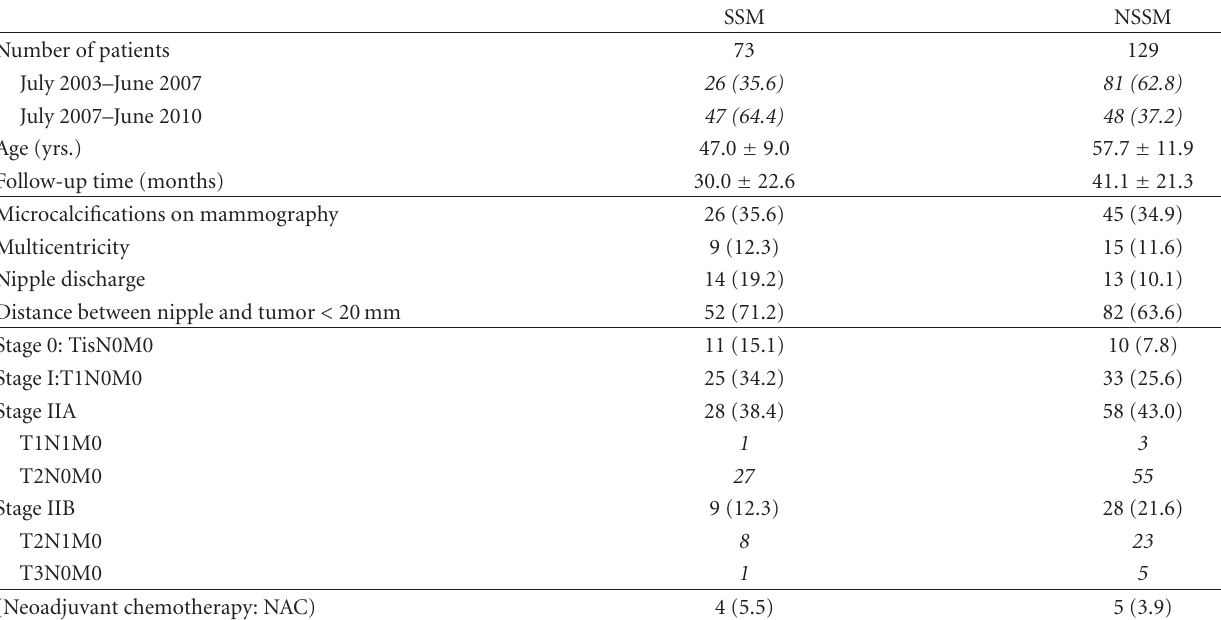
Table 1: Patients and tumor characteristics and stage in SSM and NSSM (%).